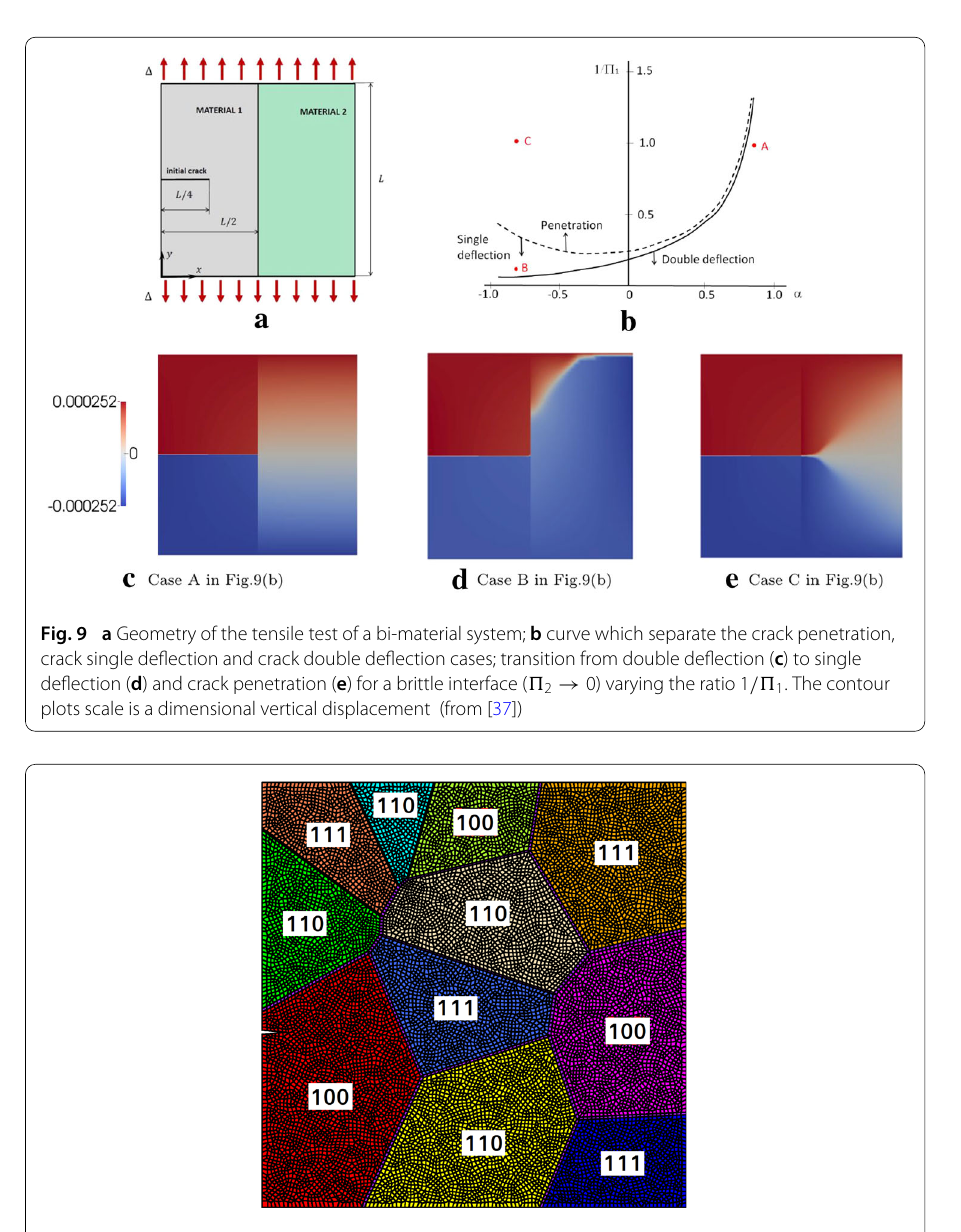
This computational model has been applied to the description of fracture of polycrys- talline silicon solar cells, see an example of finite element mesh in Fig. 10. Silicon grains were connected to each other by means of zero-thickness interface finite elements. The square domain in Fig. 10 presented an edge notch on the left side. A tensile test has been simulated by considering different values of the ratio between the grain boundary frac- ture energy and the fracture energy of the grain with orientation (cid:8) 100 (cid:9) , i.e., G gb / G (cid:8) 100 (cid:9) . The simulations showed that for low values of G gb / G (cid:8) 100 (cid:9) , failure was mostly the result of intergranular fractures (Fig. 11a). By increasing the value of the ratio G gb / G (cid:8) 100 (cid:9) ,